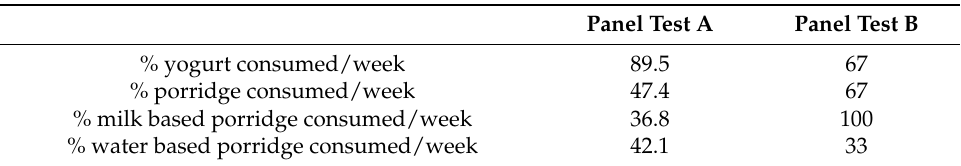
Table 5. Composition of panel test A and B. Table 5 . Composition of panel test A and B.